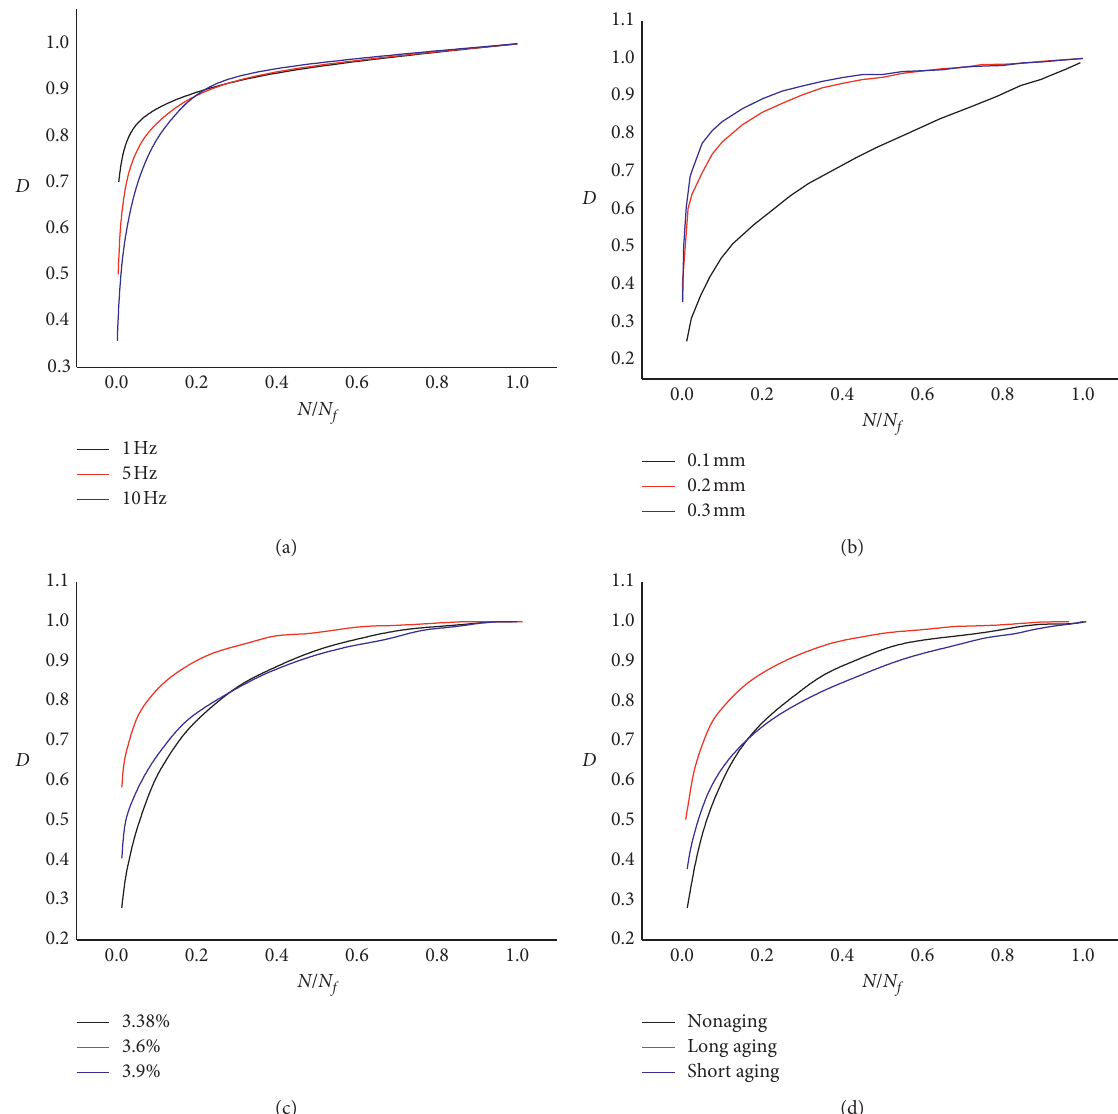
y = 1 – exp (–0.096 x –0.46 ) R 2 = 0.97